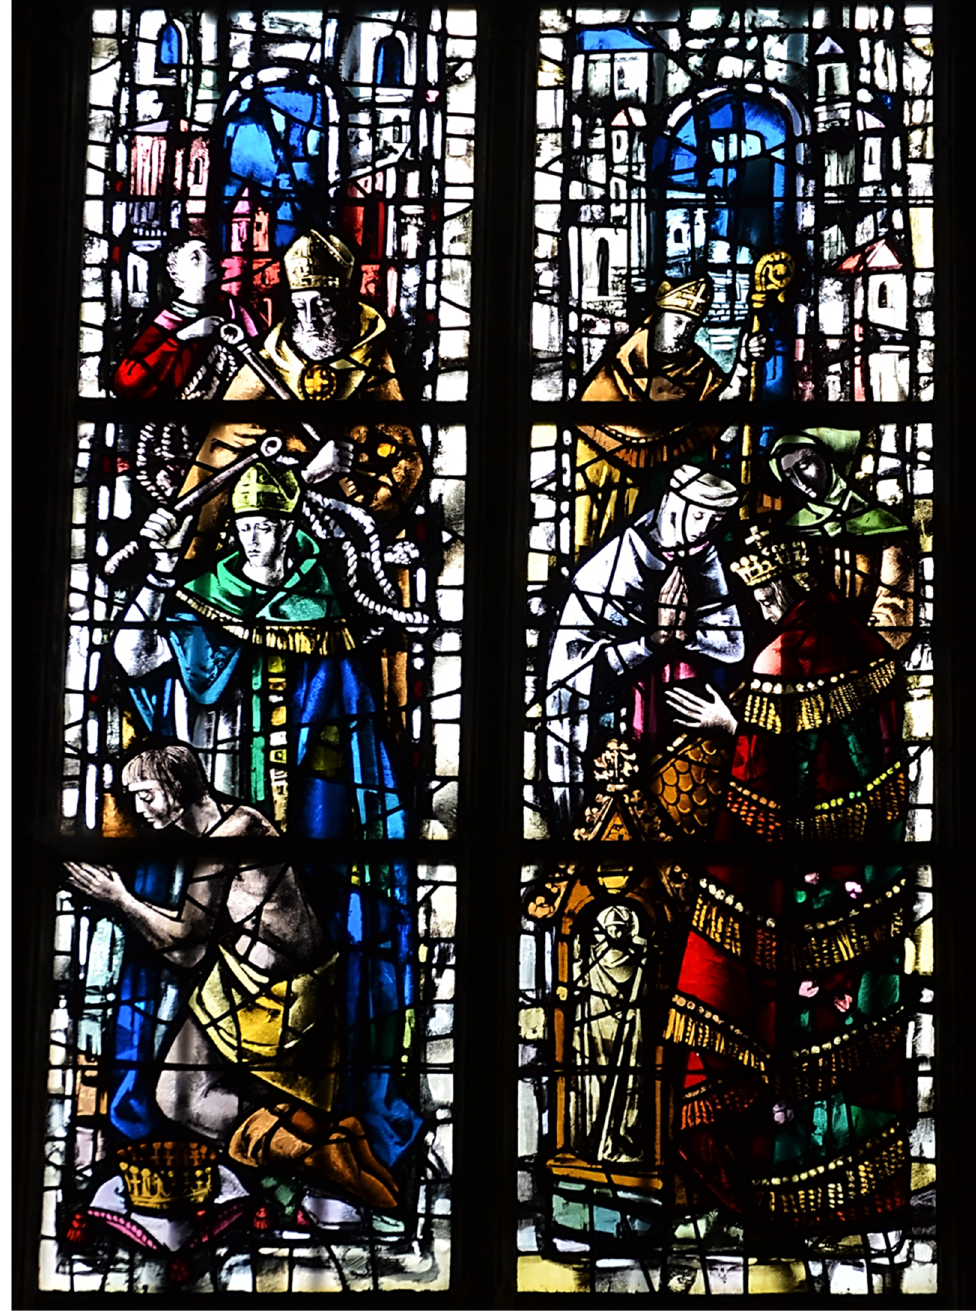
Figure 17. Saint-Lô, Church of Notre-Dame, Saint-Thomas chapel, Life of Saint Thomas window, Figure 17. Saint-L ô , Church of Notre-Dame, Saint-Thomas chapel, Life of Saint Thomas window, 1968, detail, Henry II submits to scourging and Veneration of Saint Thomas. © author. 1968, detail, Henry II submits to scourging and Veneration of Saint Thomas. ©